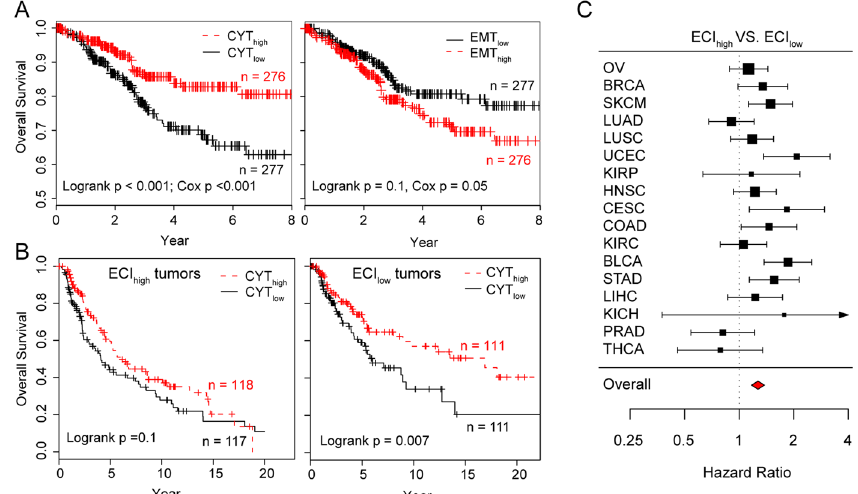
Fig. 2 Prognostic association of EMT and immune evasion interactions. A Overall survival of UCEC patients according to CYT and EMT scores. Adjusted survival curves were generated using the multivariate Cox proportional hazards model. B Overall survival of ECI high and ECI low tumors patients according to CYT and EMT scores in melanoma. C Forest plot visualizing the hazard ratios (95% con fi dence intervals) of univariate Cox proportional regression analyses for ECI across 17 types of solid cancer. CYT cytolytic activity, EMT epithelial-mesenchymal transition, ECI EMT-CYT index, UCEC uterine corpus endometrial